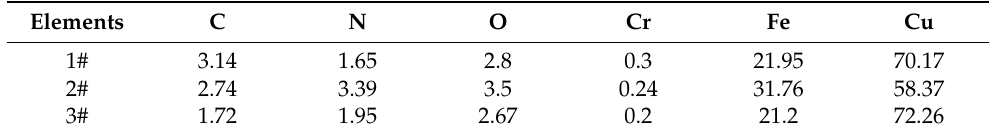
Table 3. Chemical compositions of nano-Cu/microalloyed gradient coating on 42CrMo surface after in situ nitriding process (wt.